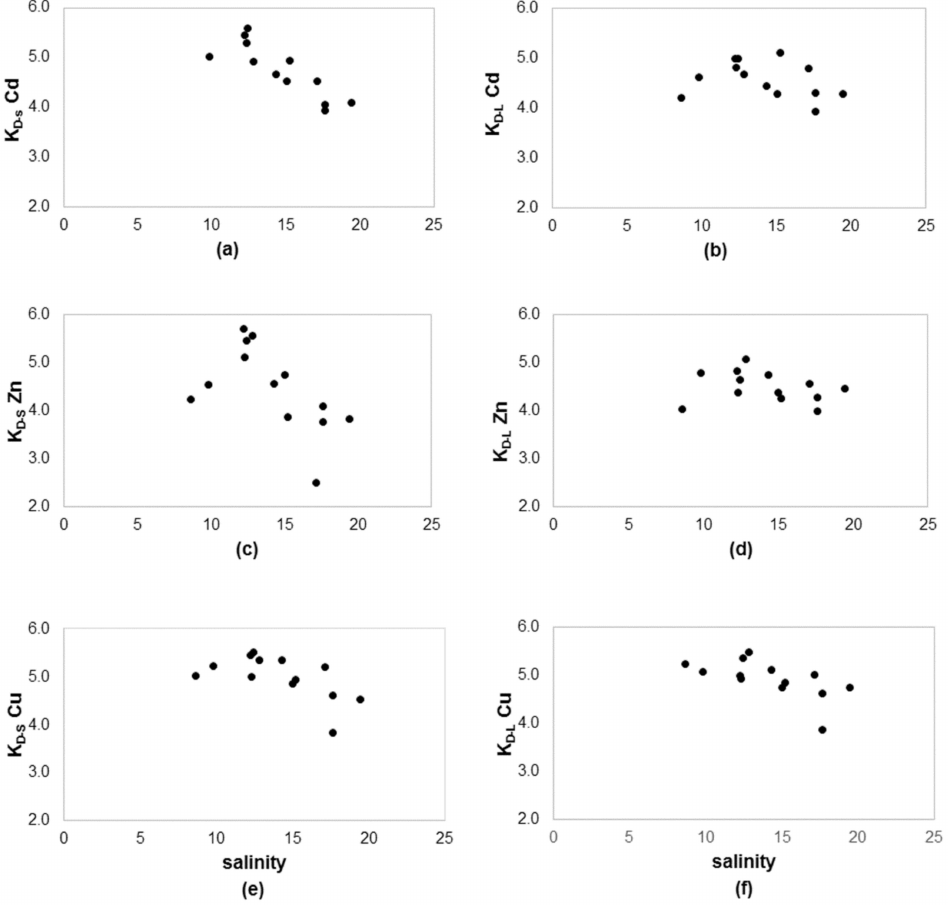
Figure 5. Variation of partition coe ffi cient (K D ) with salinity the inner part of the lagoon: ( a ) K D-S for Cd of the small particles ( < 8 µ m) ( b ) K D-L for Cd of the large particles (d < 8 µ m), ( c ) K D-S for Zn, and ( d ) K D-L for Zn, ( e ) K D-S for Cu, and ( f ) K D-L for